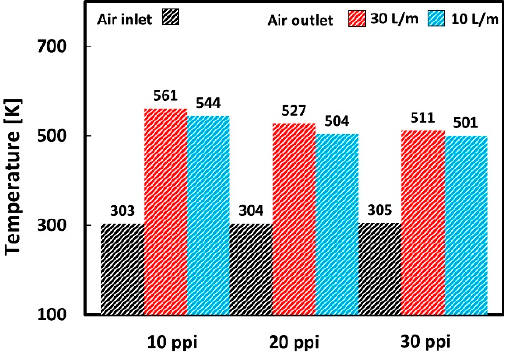
Figure 7. Air inlet and outlet temperatures data obtained during steady-state operation under different flowrates. Values were averaged over the sensors located in the absorber body.